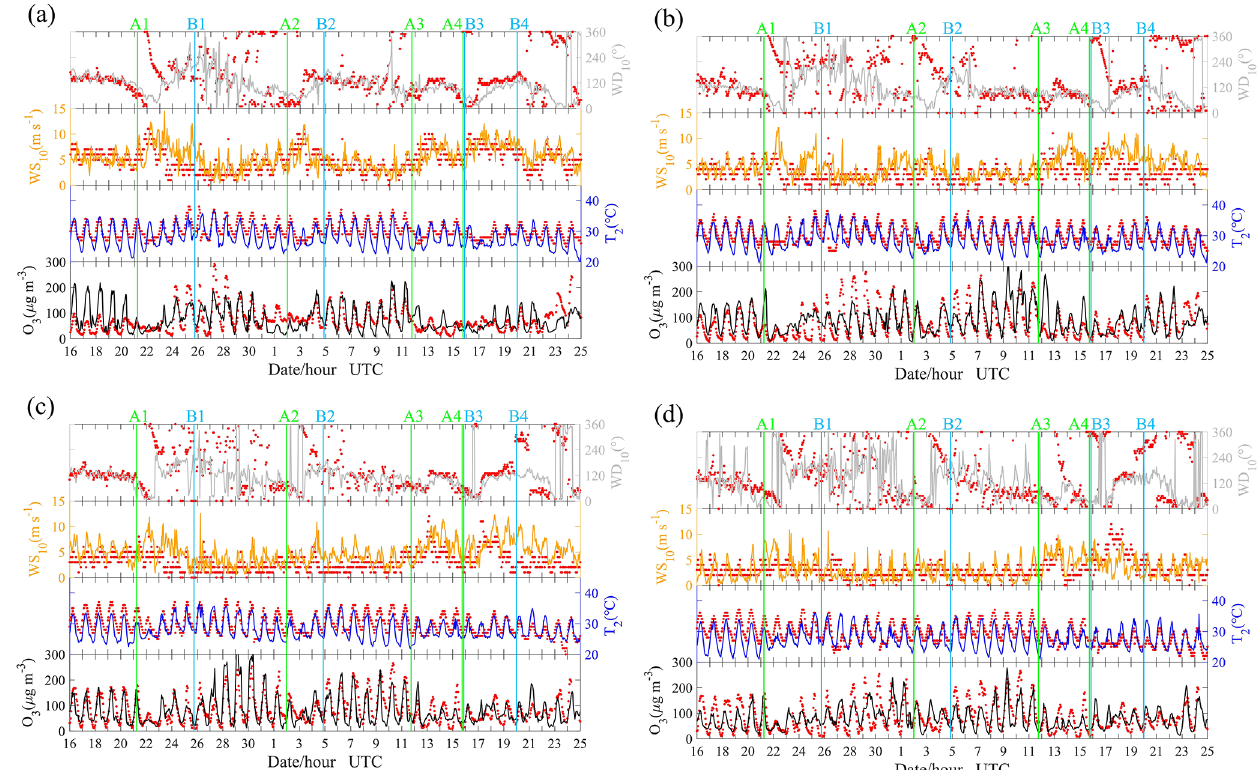
Figure 5. Hourly variations of O 3 , T 2 , WS 10 and WD 10 in measurements (red dots) and simulations (colored lines) in (a) Shanghai, (b) Hangzhou, (c) Nanjing and (d)